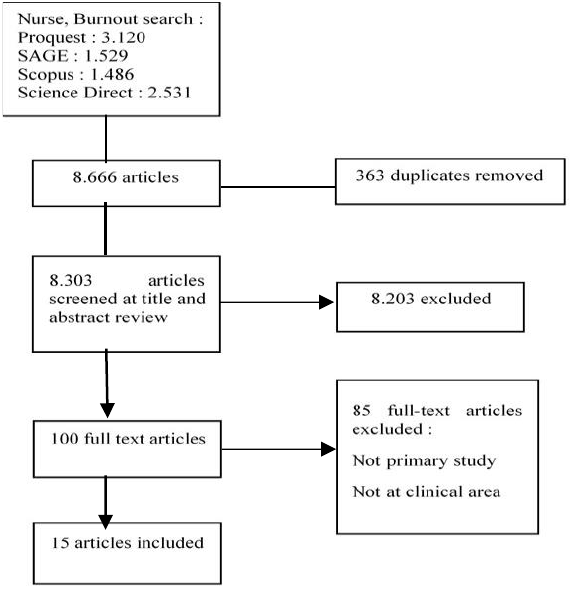
Figure 1. Flowchart of Review Process Distress